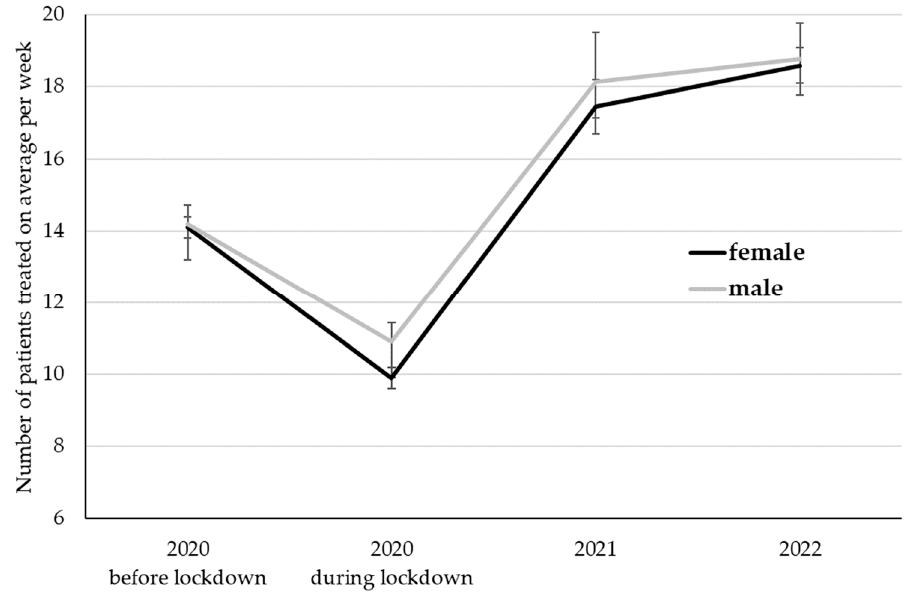
Figure 1. The number of patients treated on average per week. LS Mean ± standard error.